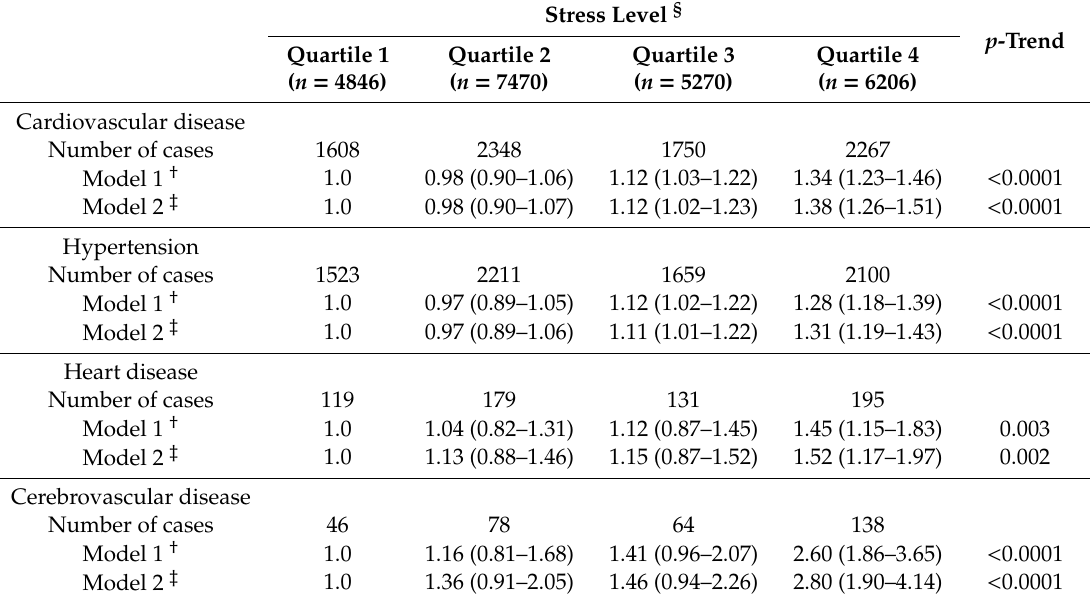
Table 2. Odds ratios (95% confidence intervals) for cardiovascular disease of participants according to quartile of stress level.